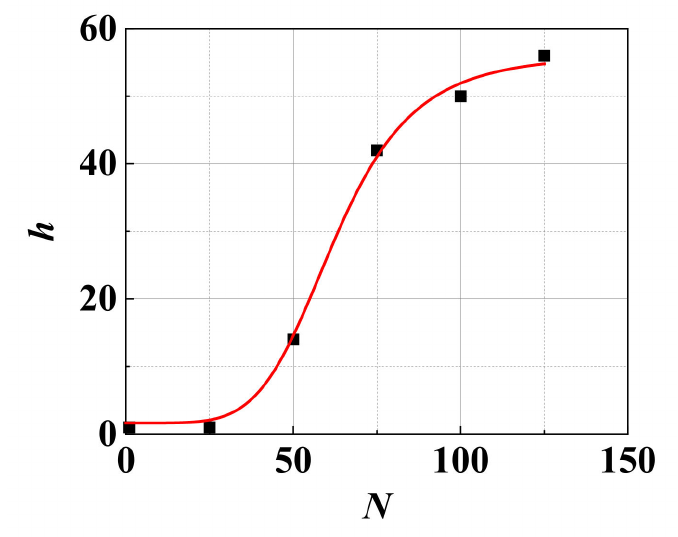
Figure 27. Relationship between freeze–thaw times and